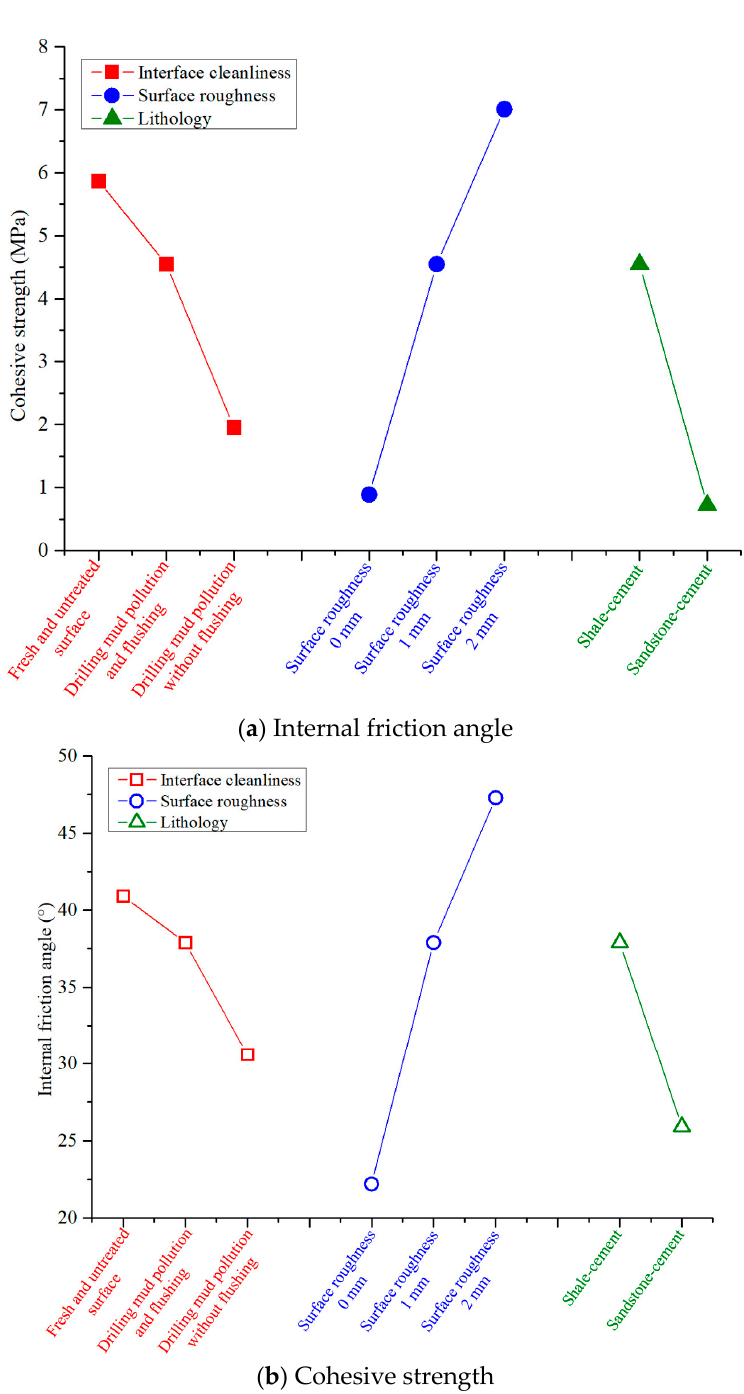
Figure 10. Variation of parameters of shear strength with different factors.